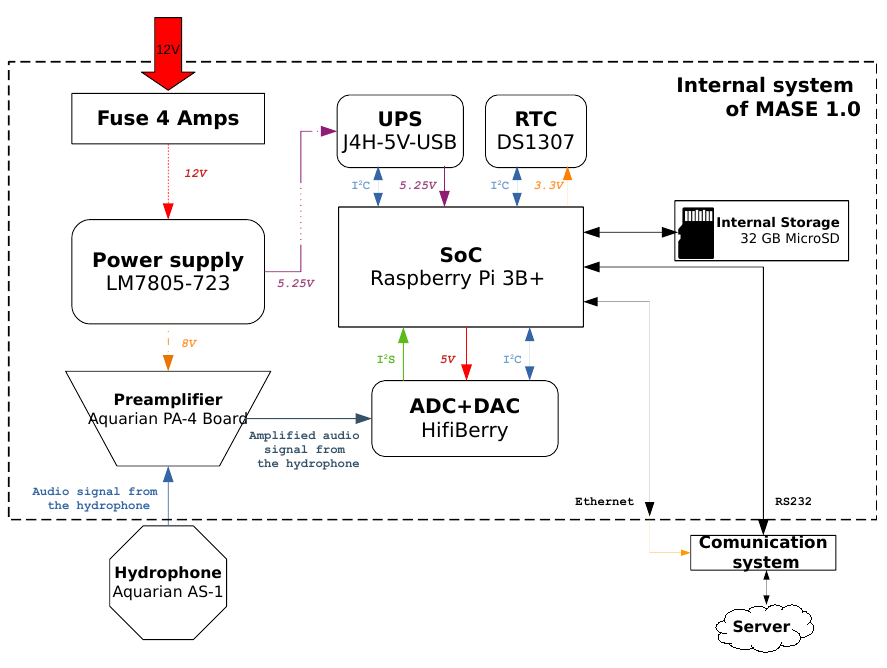
Figure 2. Proposed hardware structure for